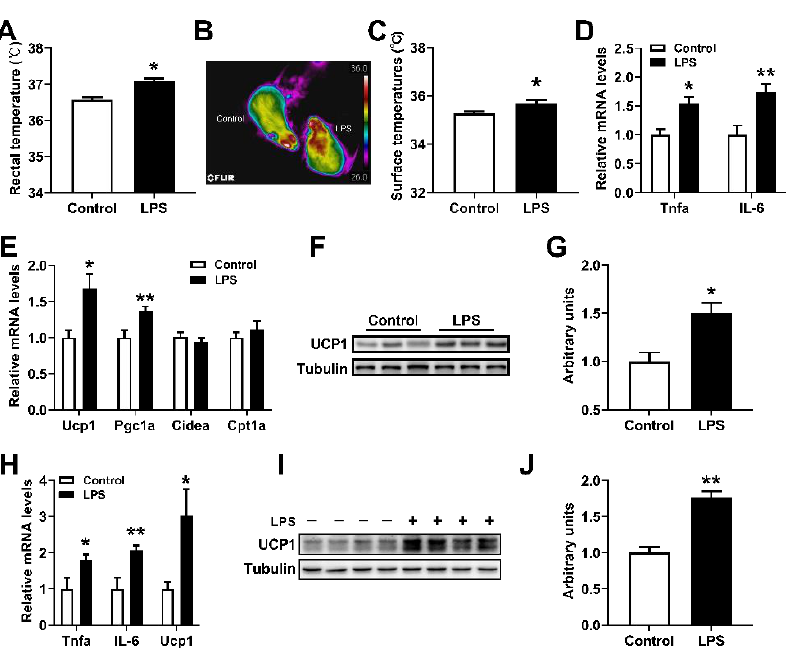
Figure 1. Low-dose LPS induced fever in mice. ( A ) Rectal temperatures of mice treated with 10 µ g/kg LPS for 1.5 h. ( B , C ) Dorsal interscapular surface imaging and temperature. ( D , E ) The inflammation- related ( D ) and thermogenic-related ( E ) mRNA expression levels in the BAT of mice treated with 10 µ g/kg LPS for 4 h (n = 6). ( F , G ) The UCP1 protein levels in the BAT. ( H – J ) The TNF α , IL-6 , Ucp1 mRNAs ( H ), and UCP1 protein ( I , J ) expression levels in primary brown adipocytes treated with or without 0.2 µ g/mL LPS. Data are presented as the mean ± SEM. * p < 0.05 vs. controls; ** p < 0.01 vs. controls, as determined by Two-tailed unpaired Student’s t -test.